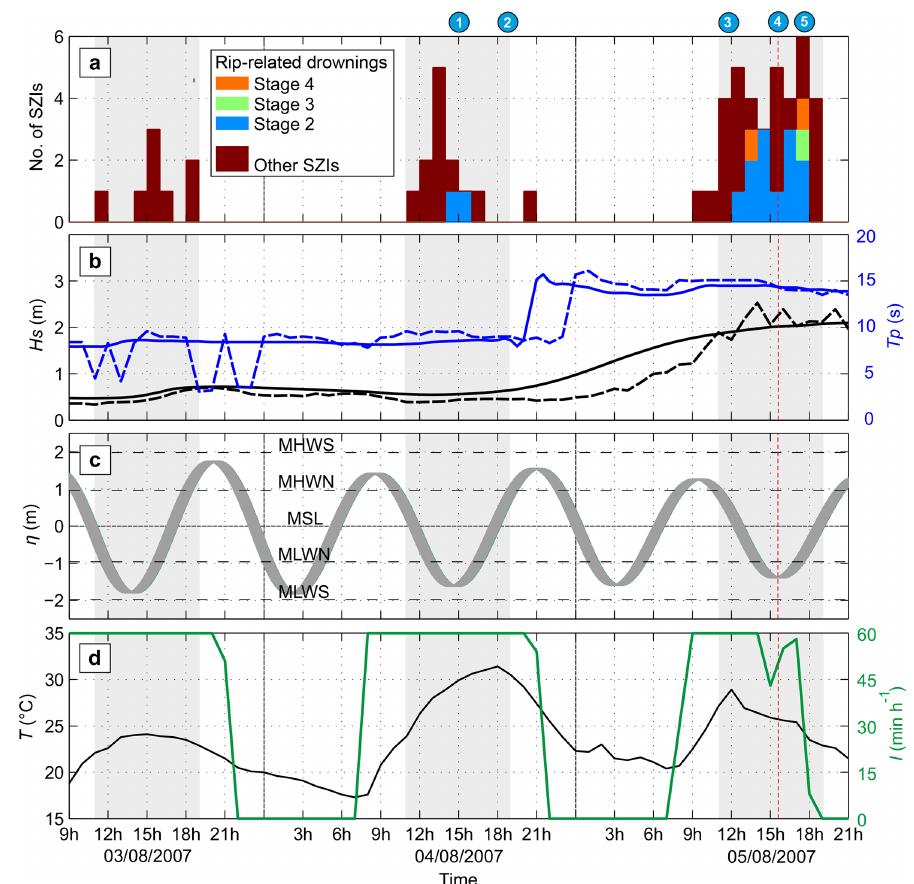
Figure 7. Time series on 3–5 August 2007, with 5 August having the largest number of rip-related drownings in the entire dataset, showing (a) distribution of SZIs, with indicators of rip-related drowning and drowning stage coloured; (b) significant wave height, Hs , and peak wave period, Tp , from the model (solid) and from the Candhis directional wave buoy in 50m depth facing Truc Vert, which worked only intermittently during the three summer seasons; (c) tide elevation, η ; (d) hourly air temperature, T , and insolation, I . In all panels, the light grey areas show the lifeguard-patrolled hours. In all panels the vertical dashed red line indicates low-tide occurrence on 5 August 2007. The blue circles on top of panel (a) indicate the timing of the wave-driven current simulations shown in Fig.